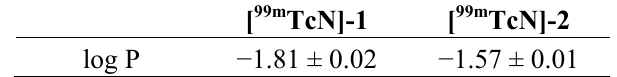
Table 1. Partition coefficients of [ 99m TcN]-1 and [ 99m TcN]-2 .